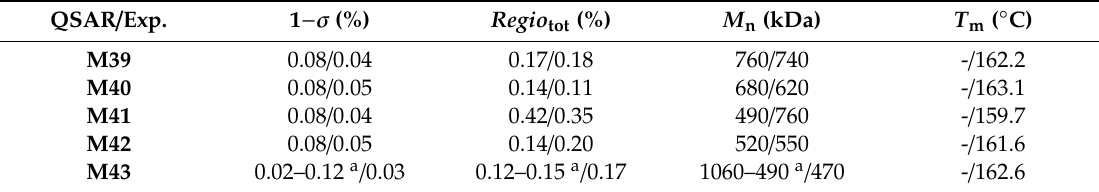
Table 8. Predicted / observed (in bold) performance properties for catalysts M39–M43 . QSAR /